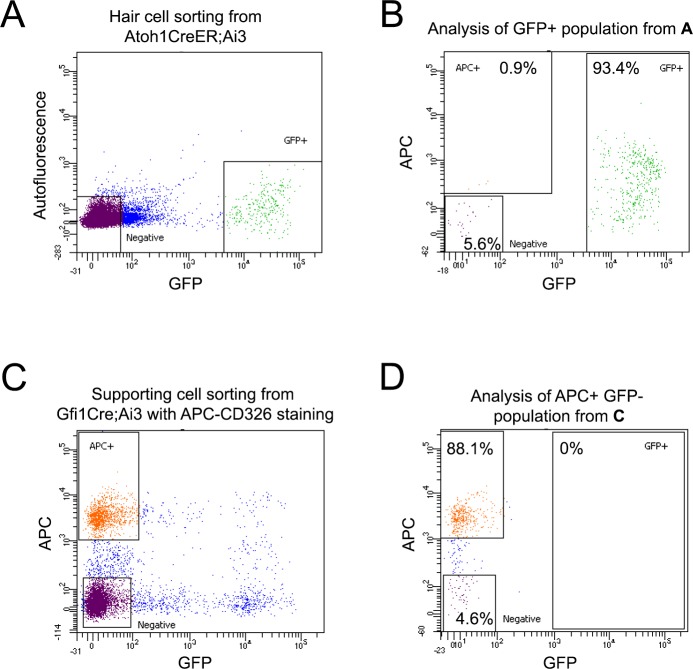
Flow cytometric analysis of sorted utricle hair cells and supporting cells.(A) Purification of utricle hair cells: Sample FACS profile showing the distribution of isolated GFP-expressing hair cells from Atoh1-CreER;Ai3 Cre reporter mice. (B) Flow cytometric analysis of re-sorted GFP +cells stained with CD326-APC. Fewer than 1% of the CD326 +epithelial cells do not express GFP. (C) Purification of utricle supporting cells: Sample FACS profile showing the distribution of isolated CD326 positive and GFP negative supporting cells from Gfi1-Cre;Ai3 Cre reporter mice. (D) Flow cytometric analysis of re-sorted supporting cells. We were not able to detect contaminating GFP-expressing hair cells in the re-sorted supporting cells.